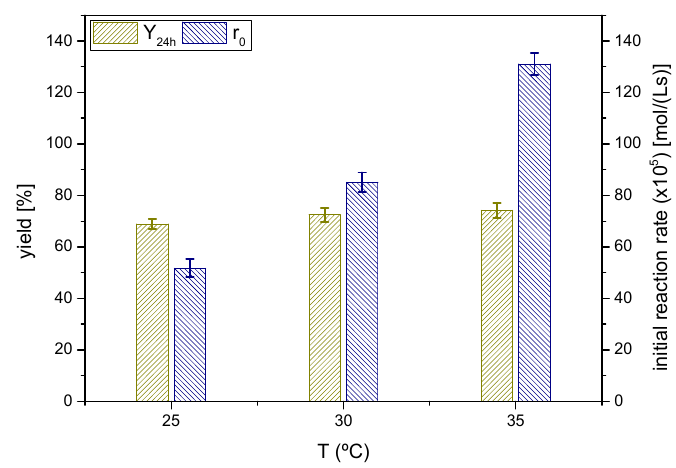
Figure 10. Influence of the reaction temperature on the yield of solketal 1 at 24 h and the initial reaction rate (Reaction conditions: acetone/glycerol molar ratio, 6:1; temperature, 25 °C).